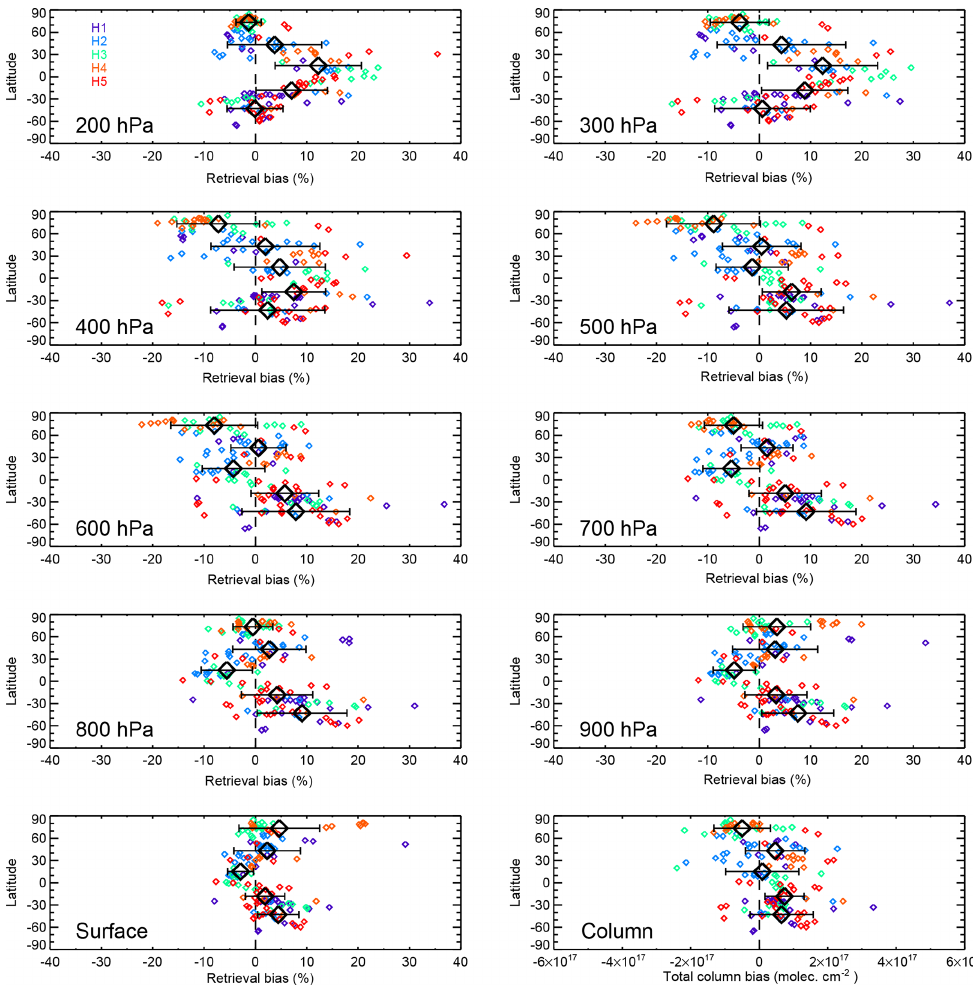
Figure 2. Latitude dependence of V7 TIR-only biases based on the HIPPO CO profiles. Results from each of the five stages of HIPPO are color-coded, as indicated by the key in the top-left panel. Large black diamonds and error bars in each panel indicate bias statistics (mean and standard deviation) representing each 30 ◦ wide latitudinal